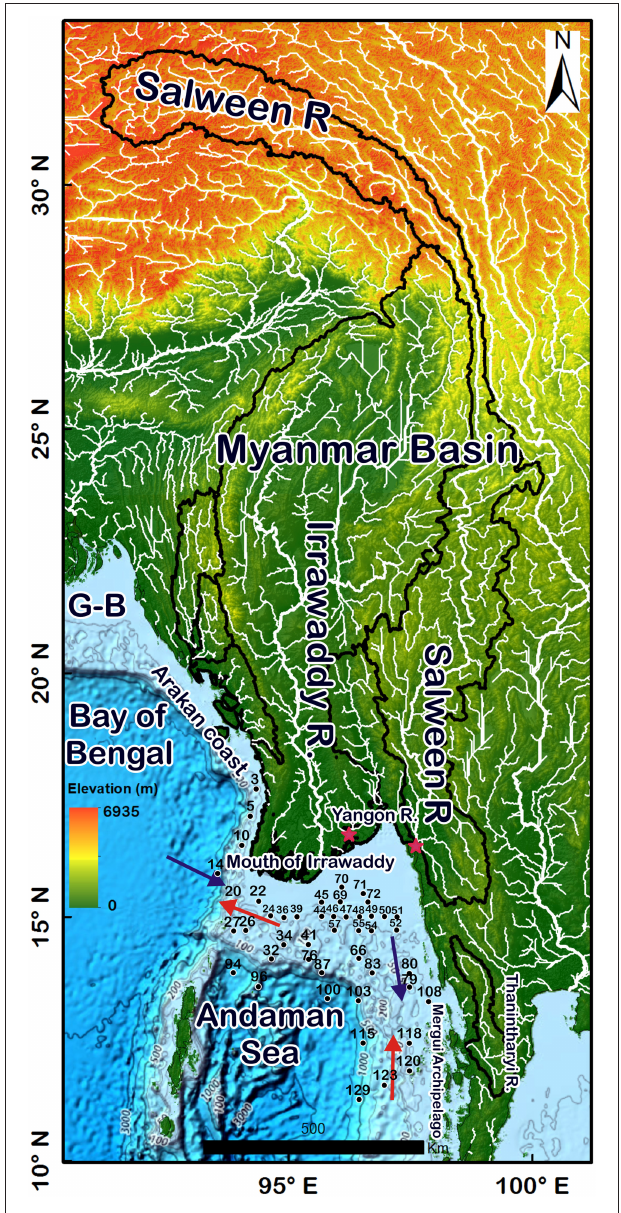
FIGURE 1 | Sediment sampling locations over the Western Myanmar and Northern and Eastern Andaman Shelves including Digital Elevation Model (DEM). Elevation of the continents is in meters and bathymetry of the Andaman Sea is given along with contours. Major rivers bringing sediments to the Andaman Sea are also shown. Stars show locations of sediments collected from the mouths of the Irrawaddy and the Salween Rivers. Black lines demarcates the different catchments. Blue and red arrows represent the surface ocean currents in the Andaman Sea during south–west and north–east monsoons respectively. Numbers near the dots are sample numbers.